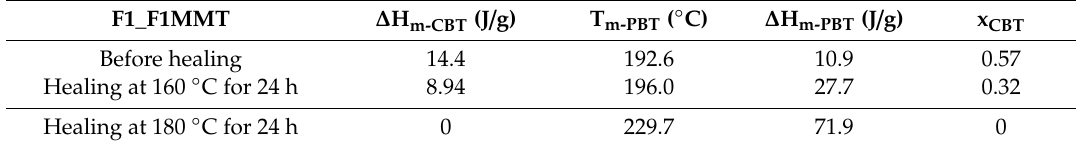
Table 5. Melting enthalpies and residual amount of CBT before and after healing of F1_F1MMT system. F1_F1MMT ∆ H m-CBT (J / g) T m-PBT ( ◦ C) ∆ H m-PBT (J / g) x CBT Before healing 14.4 192.6 10.9 0.57 Healing at 160 ◦ C for 24 h 8.94 196.0 27.7 0.32 Healing at 180 ◦ C for 24 h 0 229.7 71.9